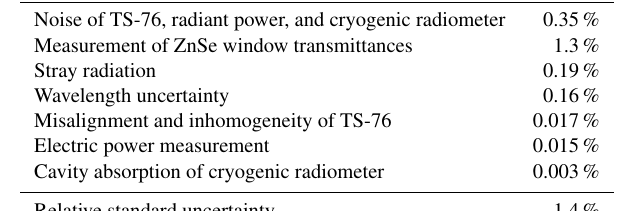
Table 3. Contributions to the relative measurement uncertainty for the measurement of the spectral responsivity of the thermally stabi- lized TS-76 against the cryogenic electrical substitution radiometer at